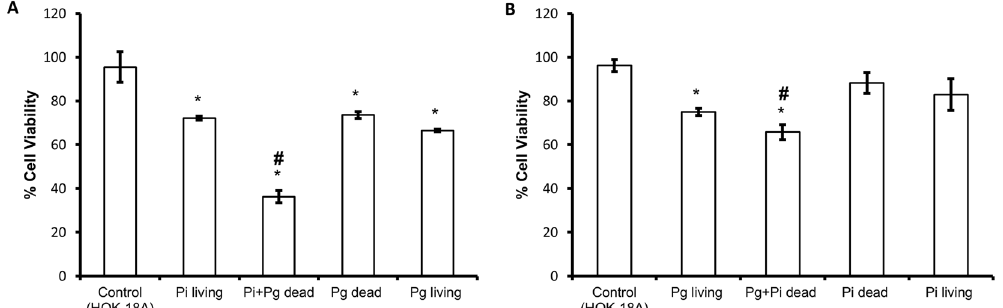
Figure 2. Percentages of cell viability after exposure to dead and living bacteria. ( A ) Percentages of cell viability in presence of living P . intermedia , dead P . gingivalis , living P . gingivalis and the combination living P . intermedia plus dead P . gingivalis . ( B ) Percentages of cell viability exposed to living P . gingivalis , dead P . intermedia , living P . intermedia and the combination living P . gingivalis plus dead P . intermedia . Control contains only cells without bacteria. * Designates a statistically significant decrease in cell viability respect to control (p < 0.05). # Designates a statistically significant decrease of cell viability respect to all conditions (p <